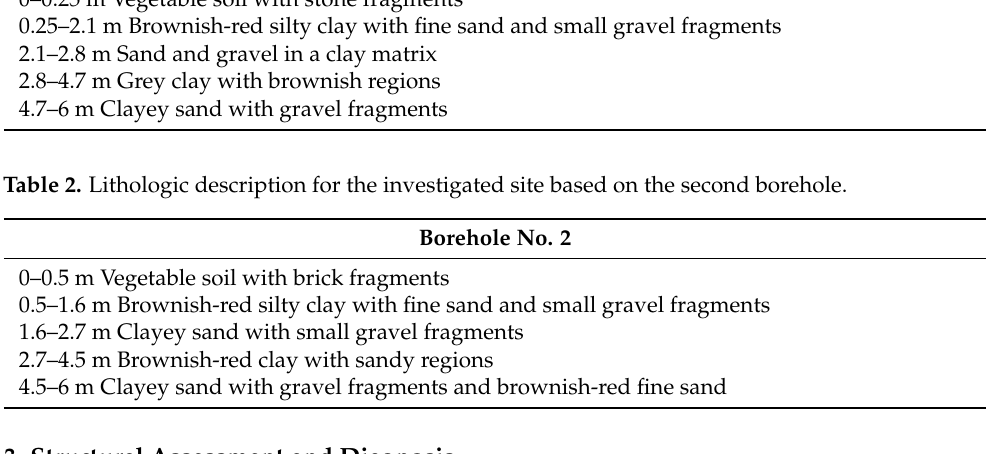
Table 1. Lithologic description for the investigated site based on the first borehole. Borehole No. 1